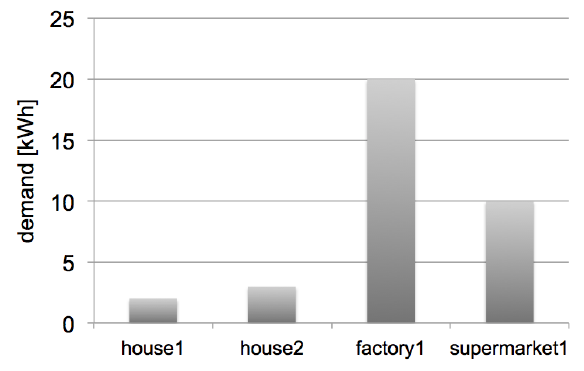
Figure 8. The demand of loads in the simulated microgrid.